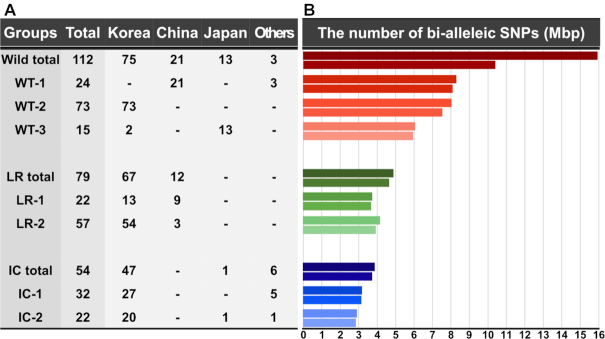
The numbers of accessions and bi-allelic SNPs for each group and subgroup. A, Distribution of accessions according to origin in each group (see Supplementary Table S1). B, Distribution of bi-allelic SNPs for each group. The x-axis indicates the number of bi-allelic SNPs concerning the reference genome (Wm82.a2.v1). The upper and lower bar plots of each group show the numbers of all bi-allelic SNPs and the bi-allelic SNPs filtered with MAF of < 1%, respectively (see Supplementary Table S3).